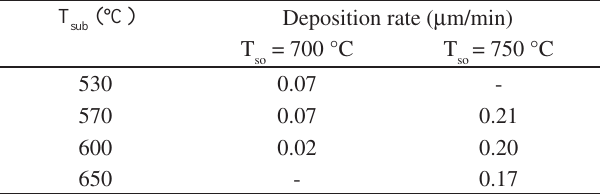
Table 1. Deposition rate of CdTe films deposited under P ferent source and substrate temperatures.